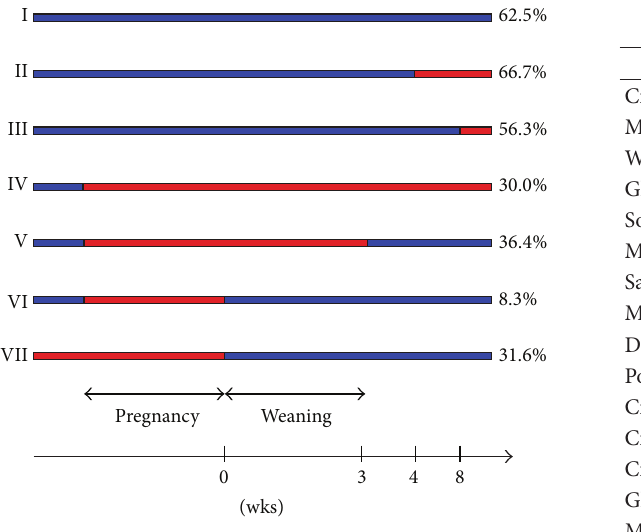
Figure 1: Experimental design of the seven groups of animals (breeding pairs and subsequent offspring). Administration of GF diet is shown in red and that of normal, gluten-containing chow is shown in blue. In groups IV–VI, the GF diet was initiated at the time of mating.